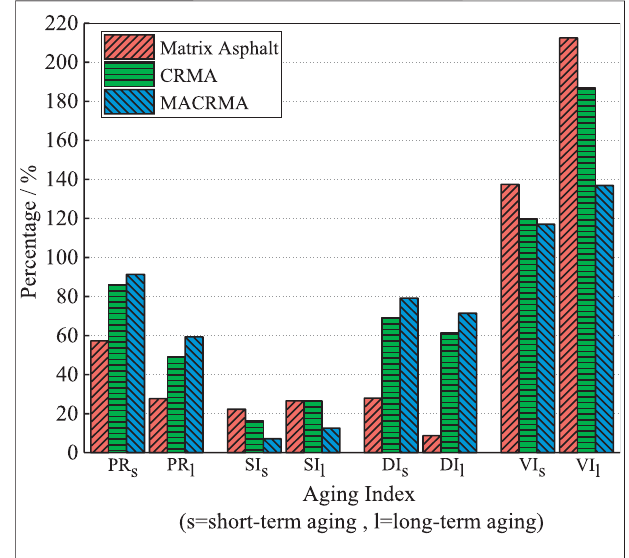
FIGURE 4 | The changes of penetration, softening point, ductility and viscosity of three kinds of asphalt during